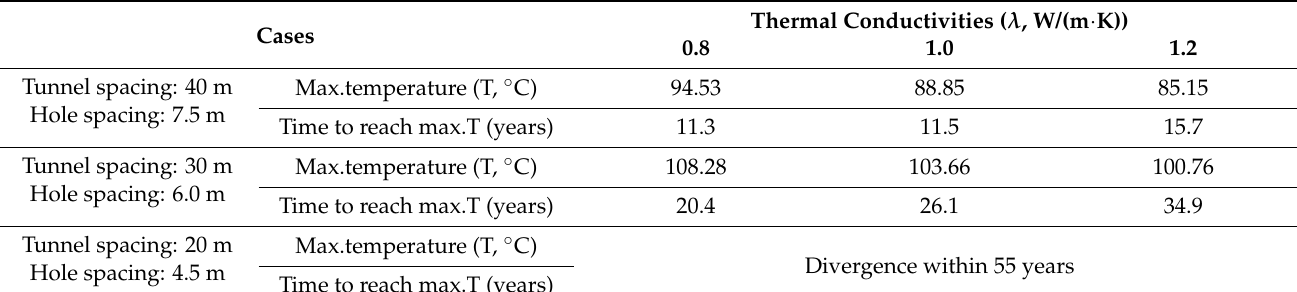
Table 4. Maximum temperature of the buffer surface facing the canister with